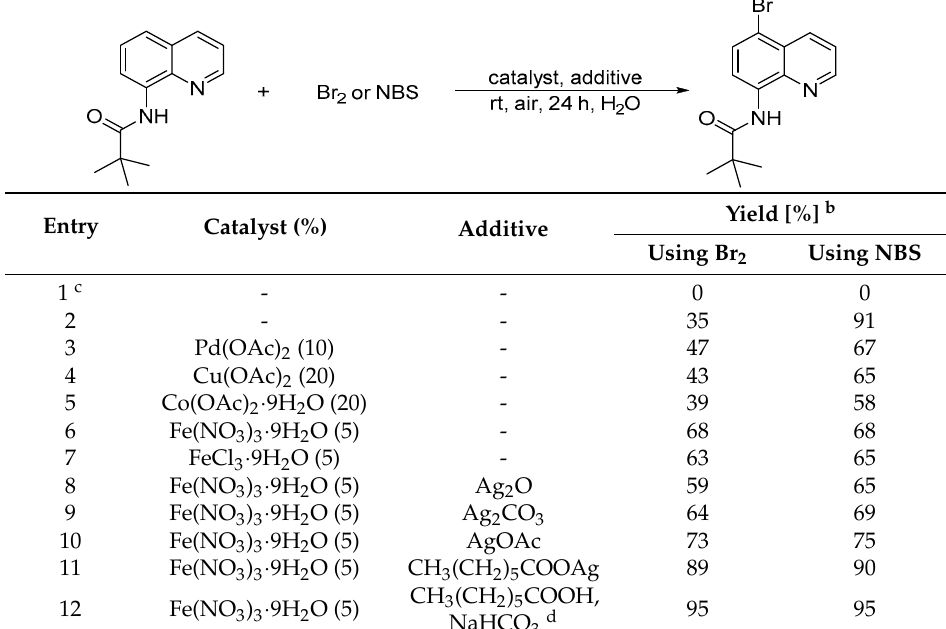
Table 1. Optimization of the reaction conditions. a